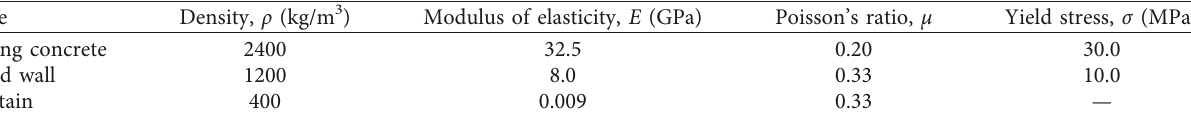
Table 2: Structural material parameters used.